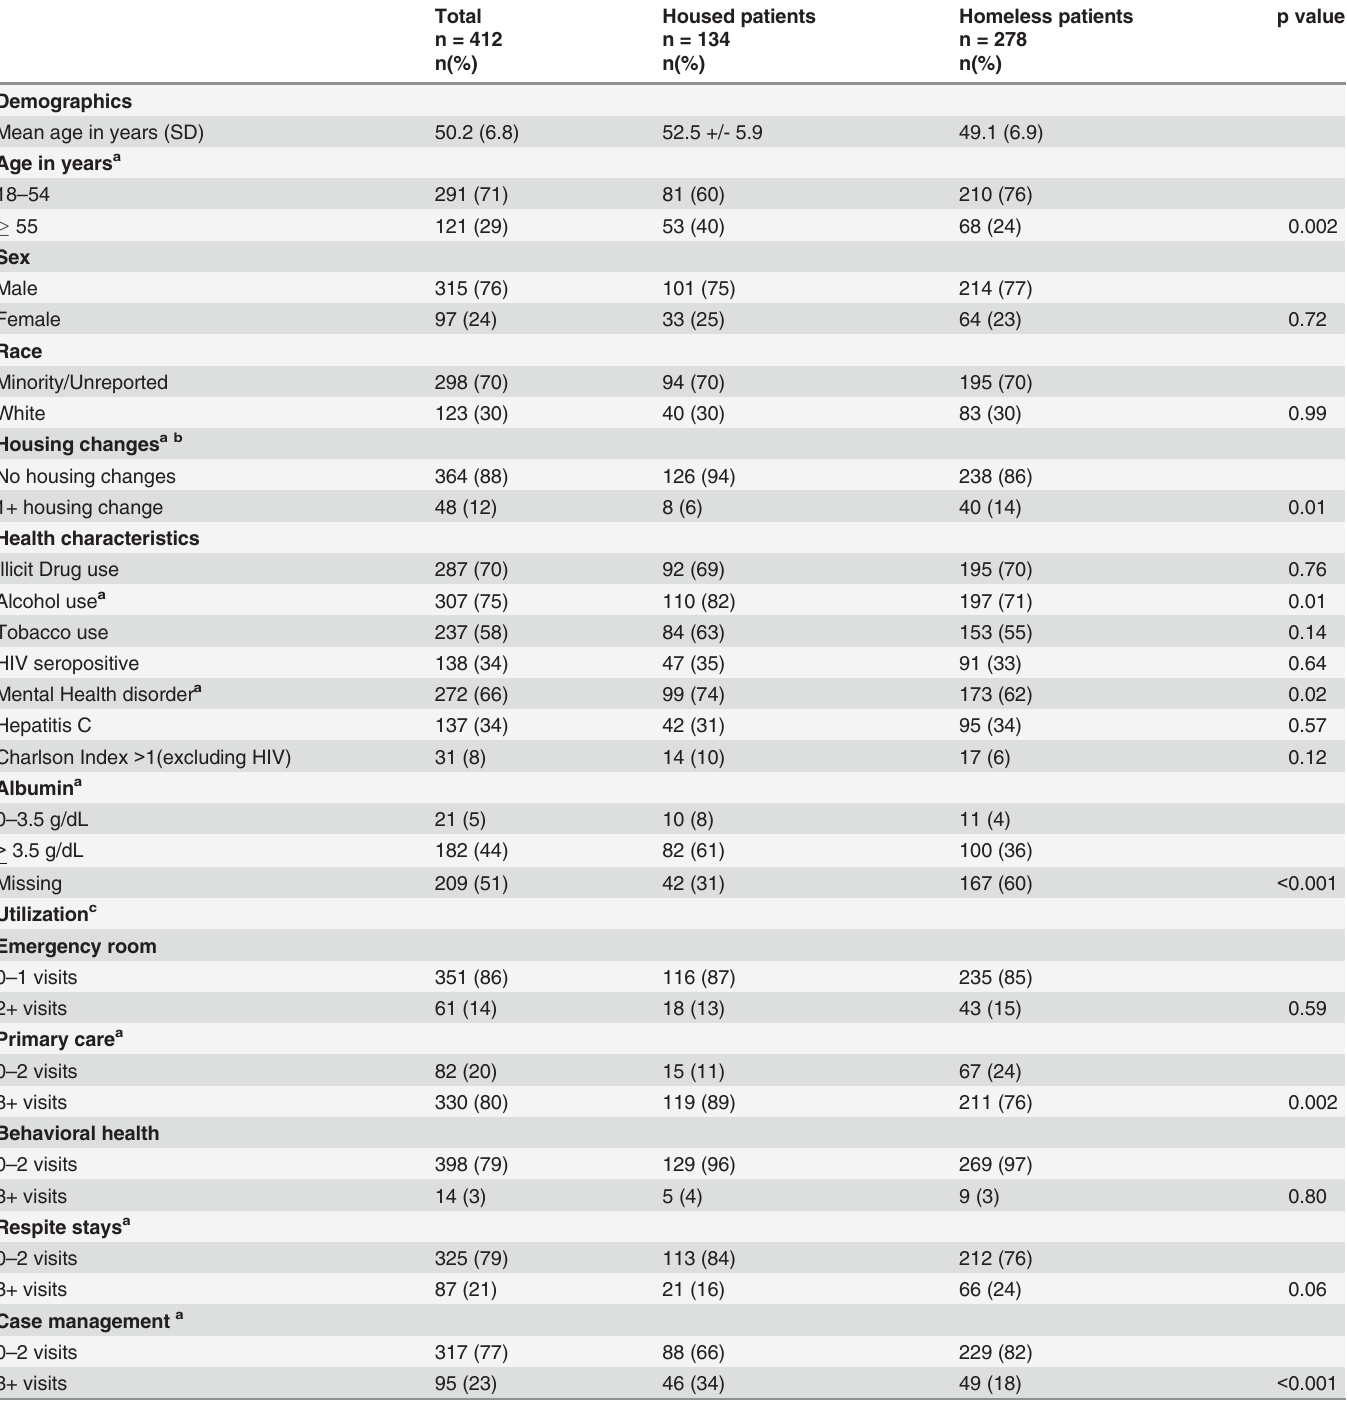
Table 1. Baseline Characteristics of Study Population by Housing